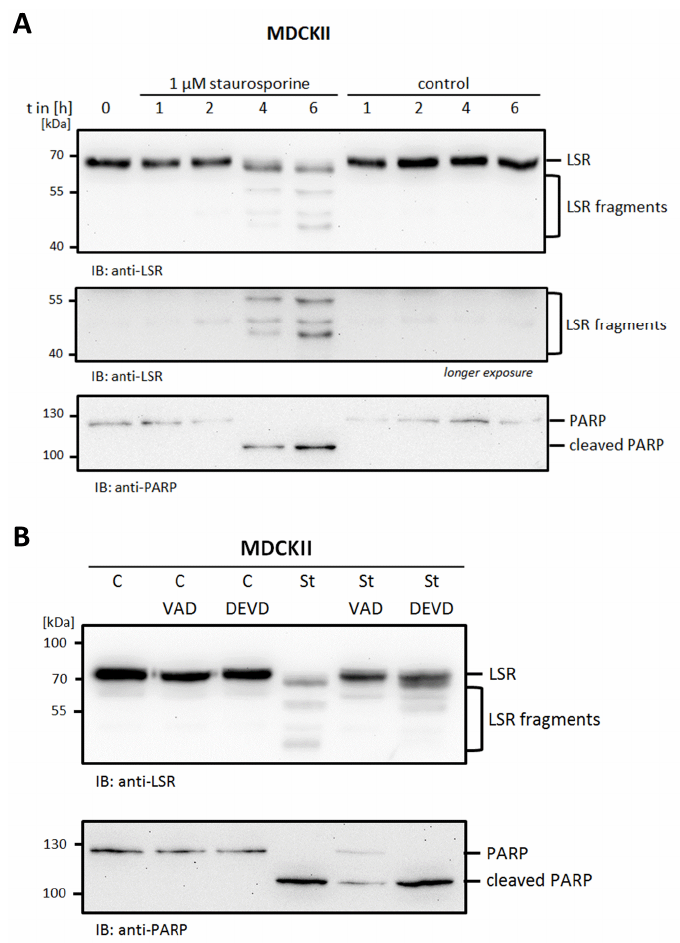
Figure 5. LSR in apoptotic cells. ( A ) Treatment of MDCKII cells with 1 µM staurosporine or solvent control for different times as indicated induced fragmentation of LSR. ( B ) Pre-treatment with caspase inhibitors (10 µM Z-VAD-FMK or 20 µM Z-DEVD-FMK for 1 h) inhibited fragmentation induced by staurosporine (1 µM for 6 h). Cell lysates were analyzed by Western blotting with anti-LSR and anti-PARP antibodies. Representative images of three independent experiments are shown.